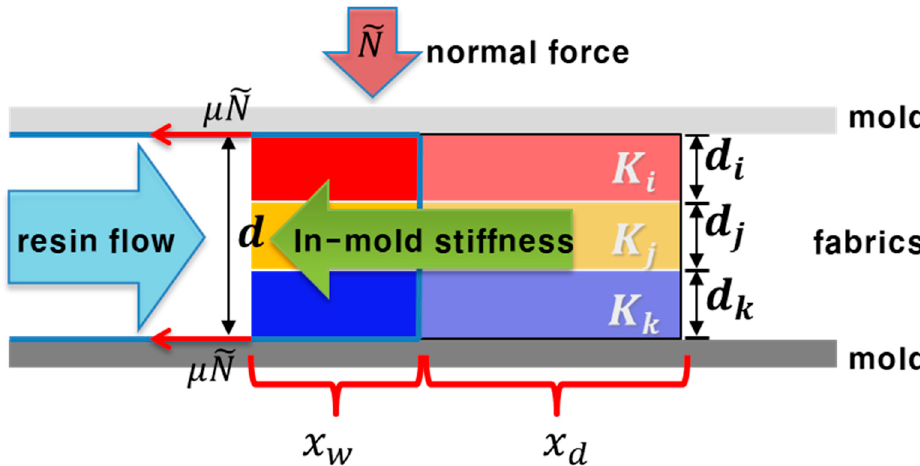
Figure 3. Schematic diagram of the relating forces and parameters during resin impregnation through the multi-layered fiber preform in resin transfer molding process. x w and w d are the lengths of wet and dry regions in the fiber preform, respectively.